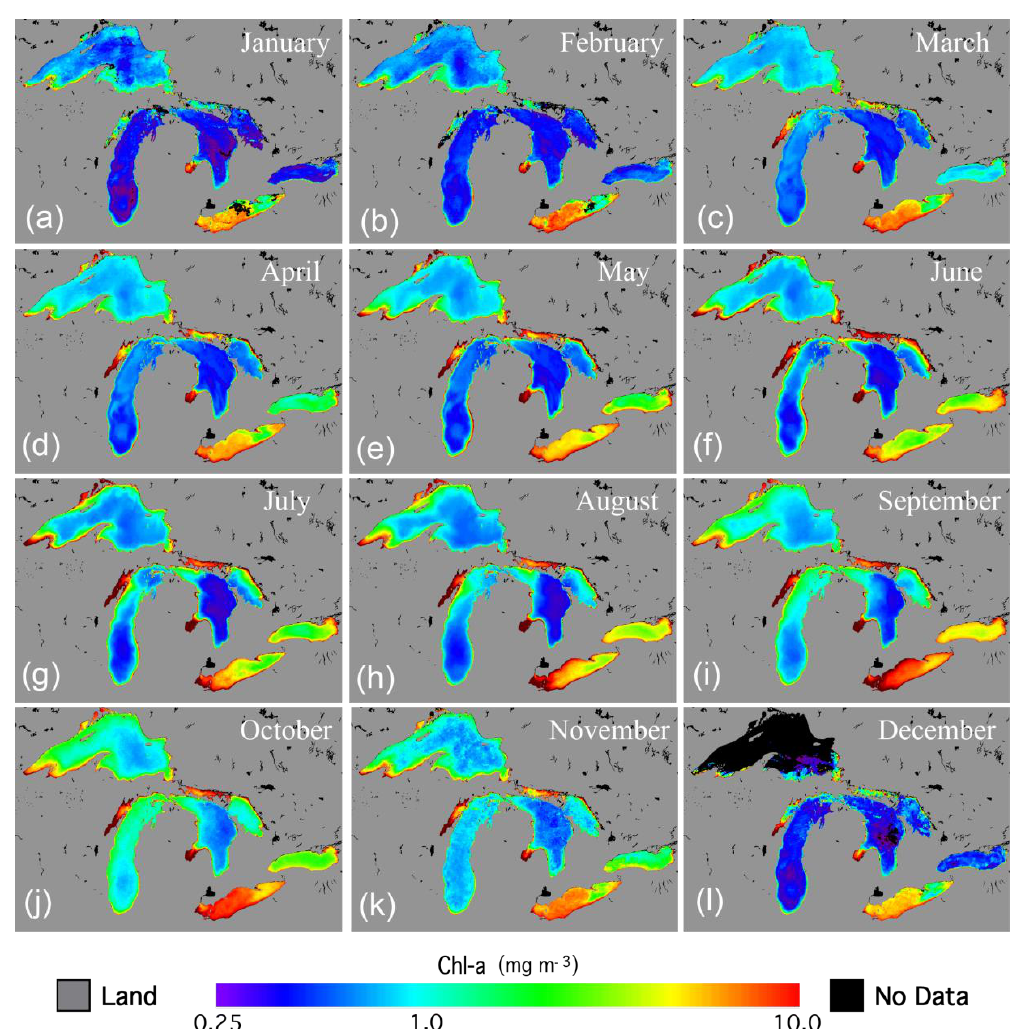
Figure 6. VIIRS-SNPP-derived climatology (2012–2019) monthly Chl-a images for January to December (a–l) in the Great Lakes.